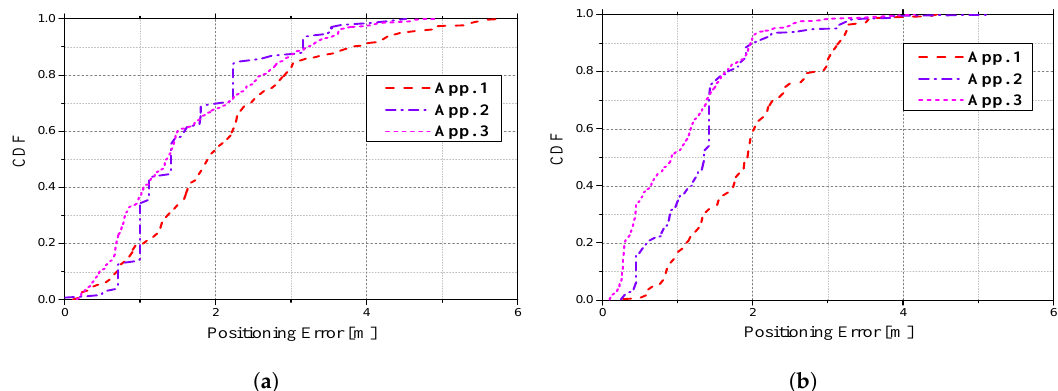
Figure 13. CDF of positioning error for each application. ( a ) Positioning error in the hall. (b) Positioning error in the